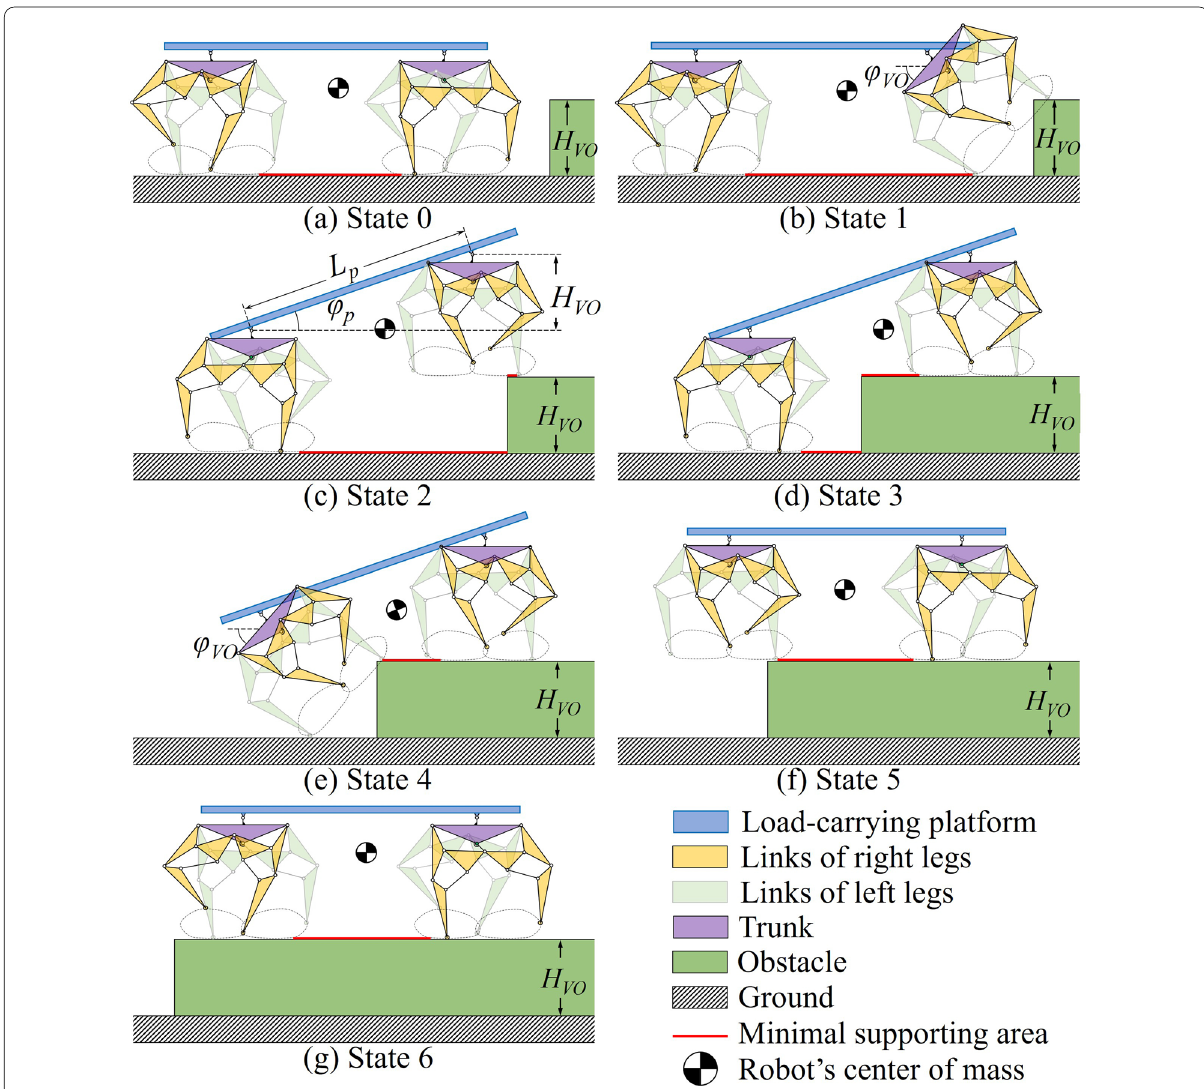
Figure 11 Vertical obstacle surmounting strategy